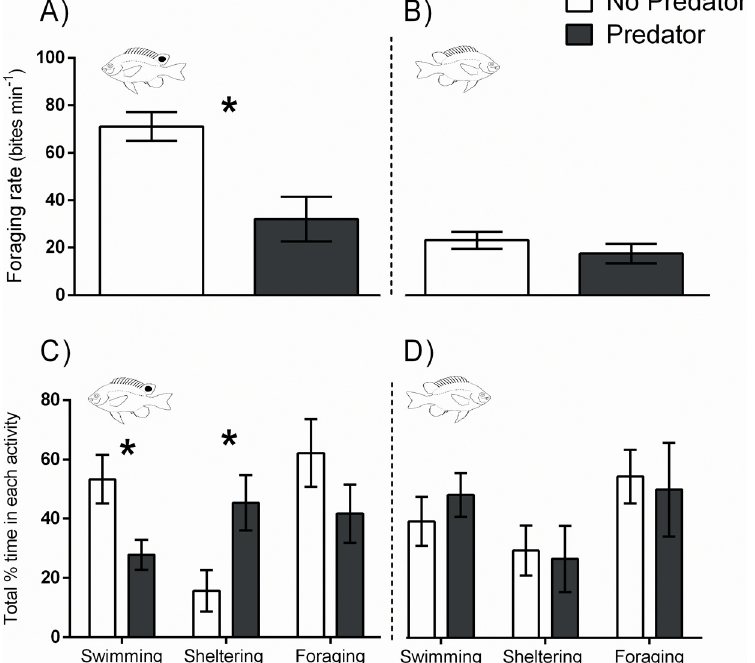
Fig 4. Foraging rates of P . amboinensis (A) and P . moluccensis (B), and activity patterns of P . amboinensis (C) and P . moluccensis (D), between predator treatments. All data are for single fish (PA1 and PM1) only with no competitor present. Asterisks indicate significant differences between predator treatments for each species (t-tests); all bars show means ± 1